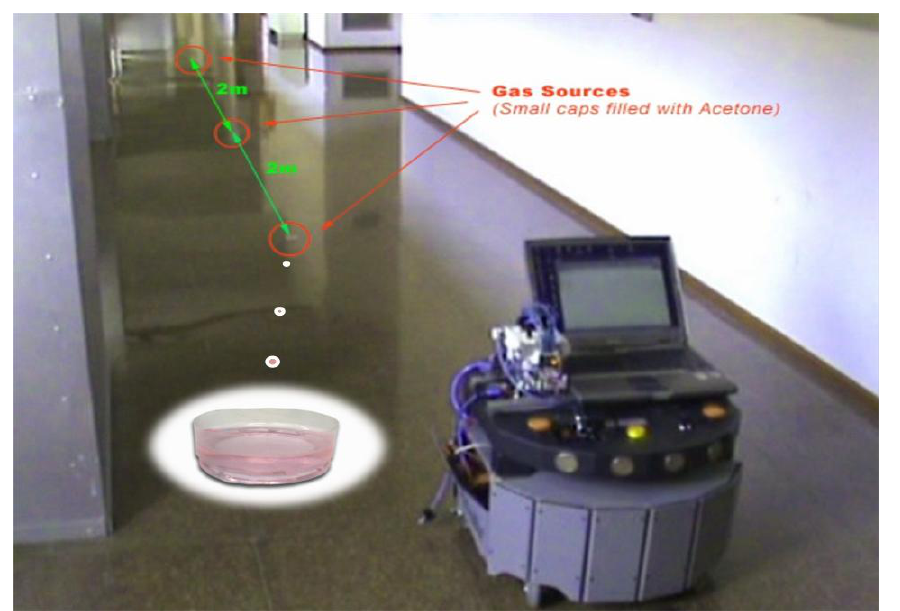
Figure 13. Description of the multiple gas source experiment. Three small cups filled with acetone where placed along the robot trajectory to test the behavior of the MCE-nose.